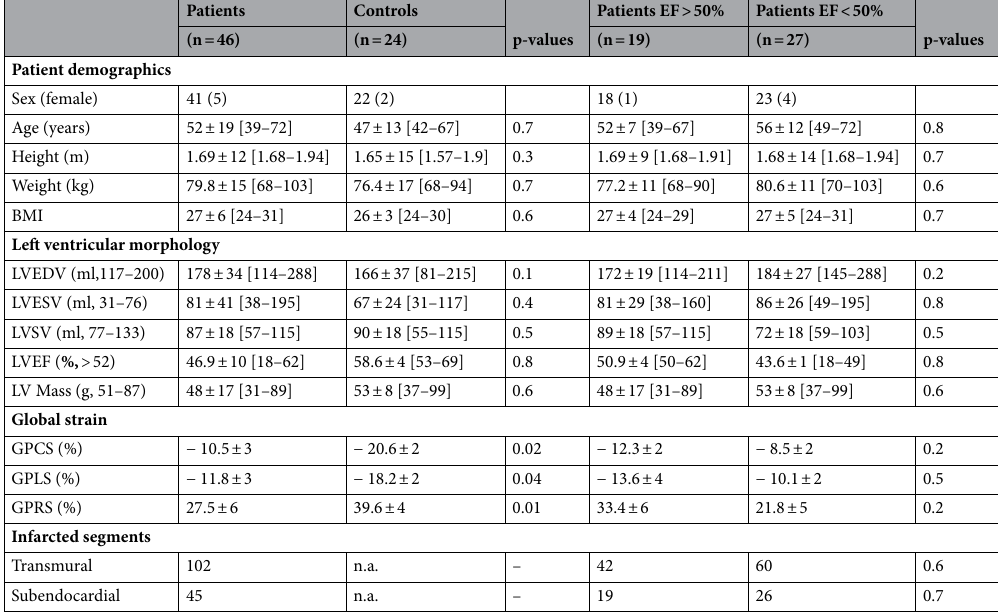
Table 1. Demographic characteristics of patients and controls. BMI body mass index, LVEDV left ventricular end-diastolic volume, LVESV left ventricular end-systolic volume, LVSV left ventricular stroke volume, LVEF left ventricular ejection fraction; values in round brackets are standard, cohort specific LV values; values in square brackets represent the value range; patients were further subdivided in two groups (grey labeling): left ventricular EF > 50% (n = 19) and EF < 50% (n =